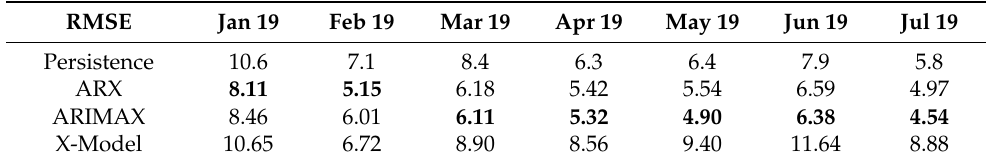
Table 2. Average RMSE scores for each method per test month. The best scores per month are in bold.